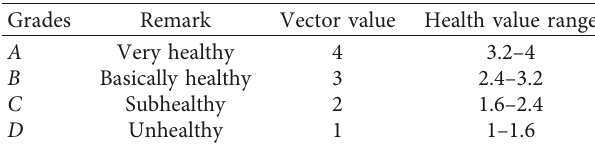
Table 2: Quantitative classification of health